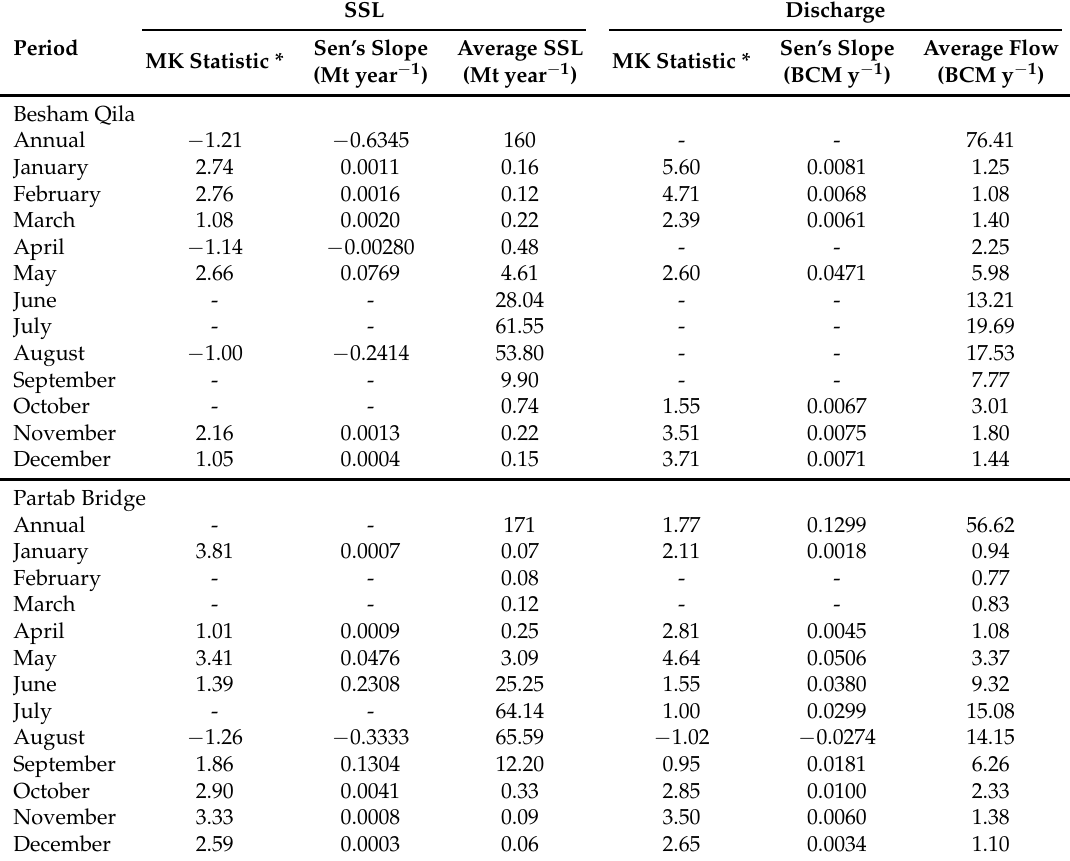
Table 4. Mann–Kendall’s (MK) annual and monthly SSL and discharge trends for the Besham Qila and the Partab Bridge sites. The minus symbol for the MK statistics indicates a downward trend, whereas the (-) symbol without numbers means no